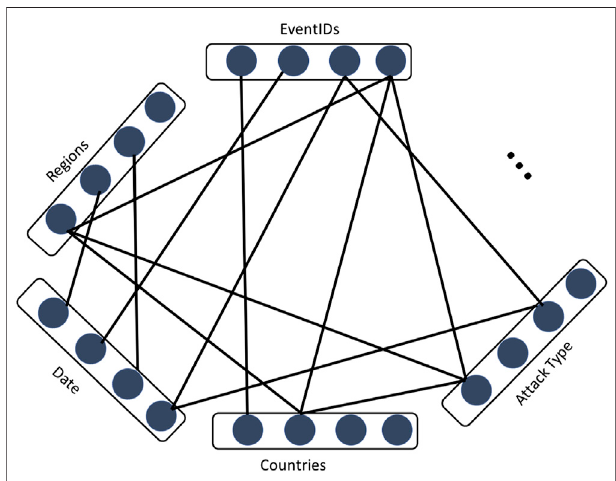
FIGURE 3 | Events modeled as nodes in a multi-partite semantic network (MPSN). We only consider events that have at least one piece of information associated with it (besides an event